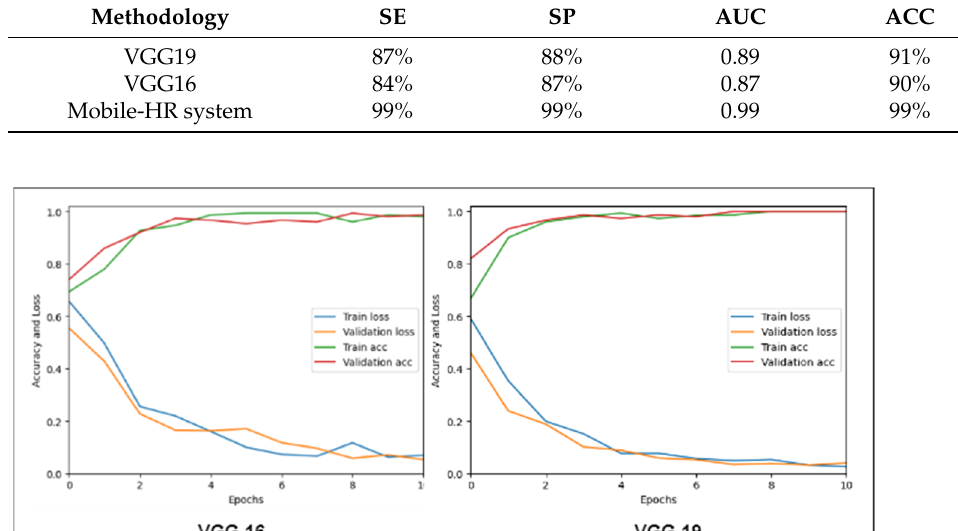
Figure 12. Training validation accuracy and training validation loss of both VGG16 and VGG19.